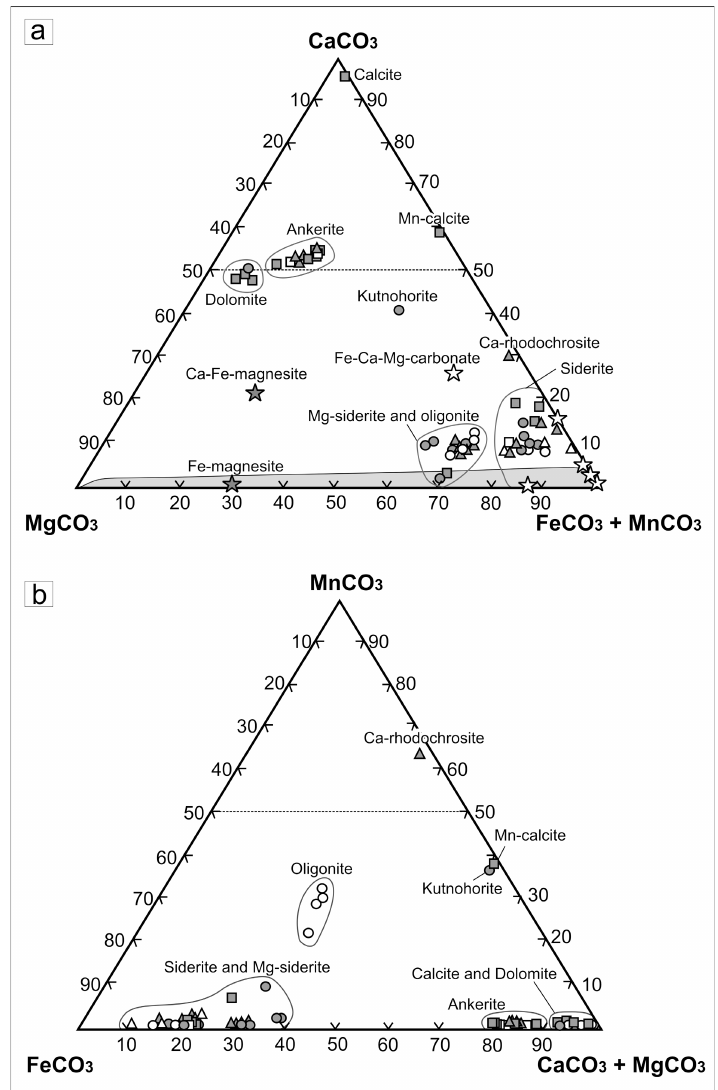
Figure 10. Triangular diagrams: ( a ) CaCO 3 –MgCO 3 –(FeCO 3 + MnCO 3 ) and ( b ) FeCO 3 –MnCO 3 –(CaCO 3 + MgCO 3 ) showing the composition of authigenic carbonates from mud masses (Bulganak area). Triangles—Andrusov Hill, squares—Trubetskoy Hill, circles—Tischenko Hill; open symbols—fine-grained carbonates ( ≤ 5 µm), filled symbols—large carbonate crystals (>10 µm). Asterisks are compositions of carbonates synthesized at 25 °C (open symbols) and 70 °C (filled symbols) [77]. Shadowed field corresponds to siderite-magnesite solid solutions synthesized at 250 °C [78].